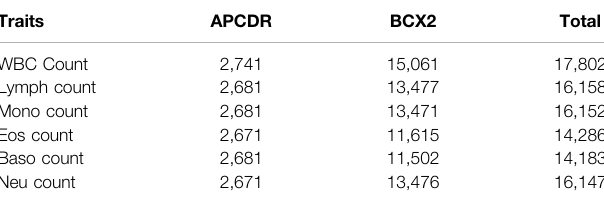
TABLE 1 | Total number of samples analyzed in APCDR and BCX2.